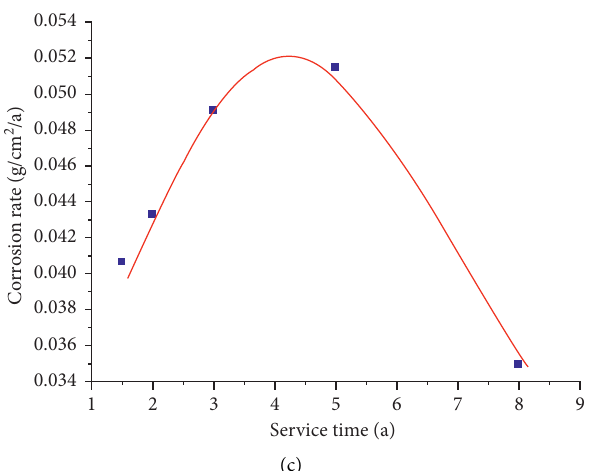
Figure 5: Variation of corrosion rate in different parts of the bolt. (a) Free section. (b) Anchor end. (c) Anchor